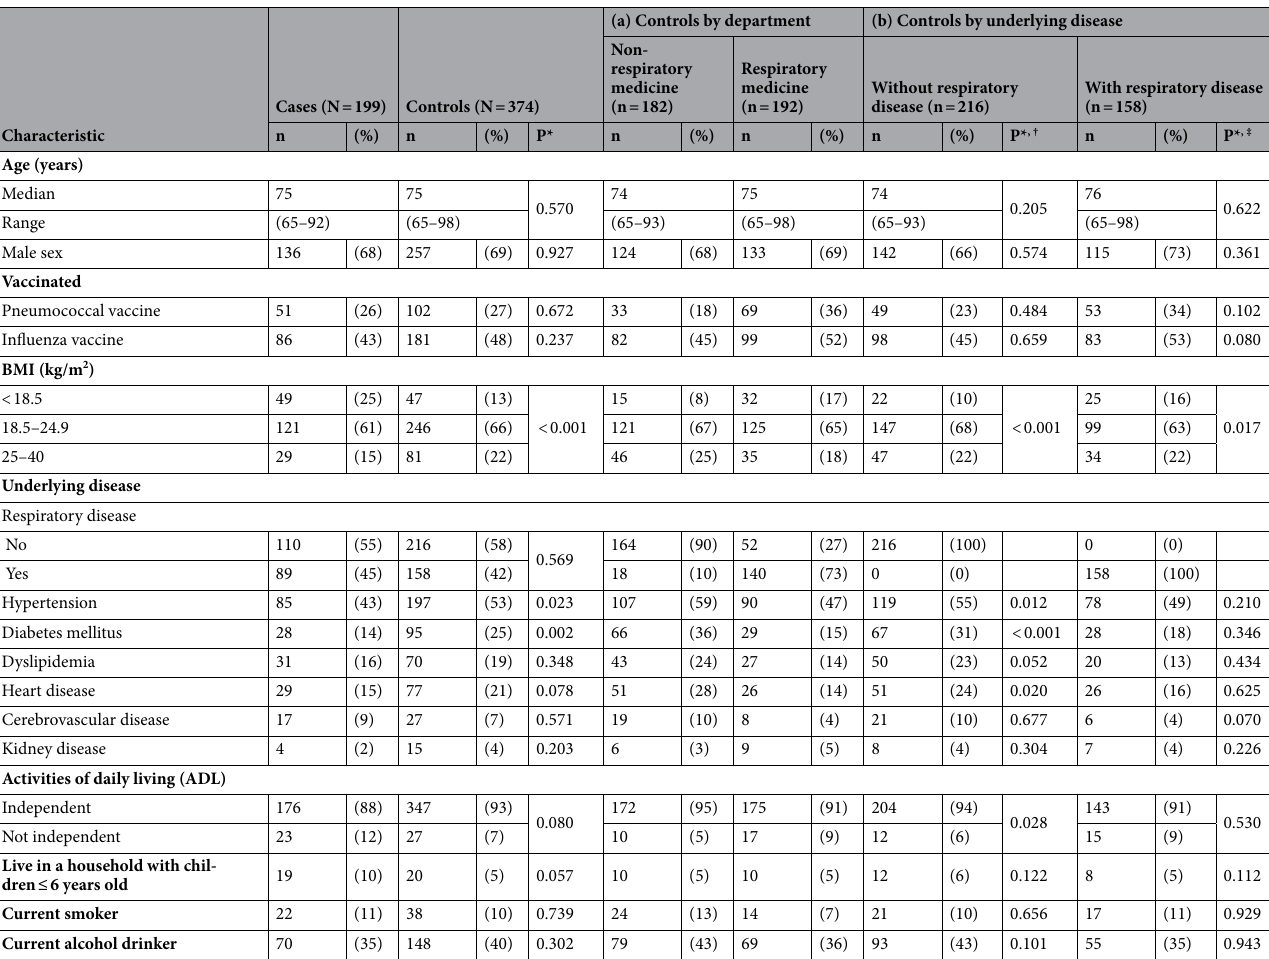
Table 1. Comparison of characteristics. *Wilcoxon rank-sum test or Chi-square test or Fisher exact test. † P between all cases (N = 199) and controls without respiratory disease (N = 216). ‡ P between all cases (N = 199) and controls with respiratory disease (N =